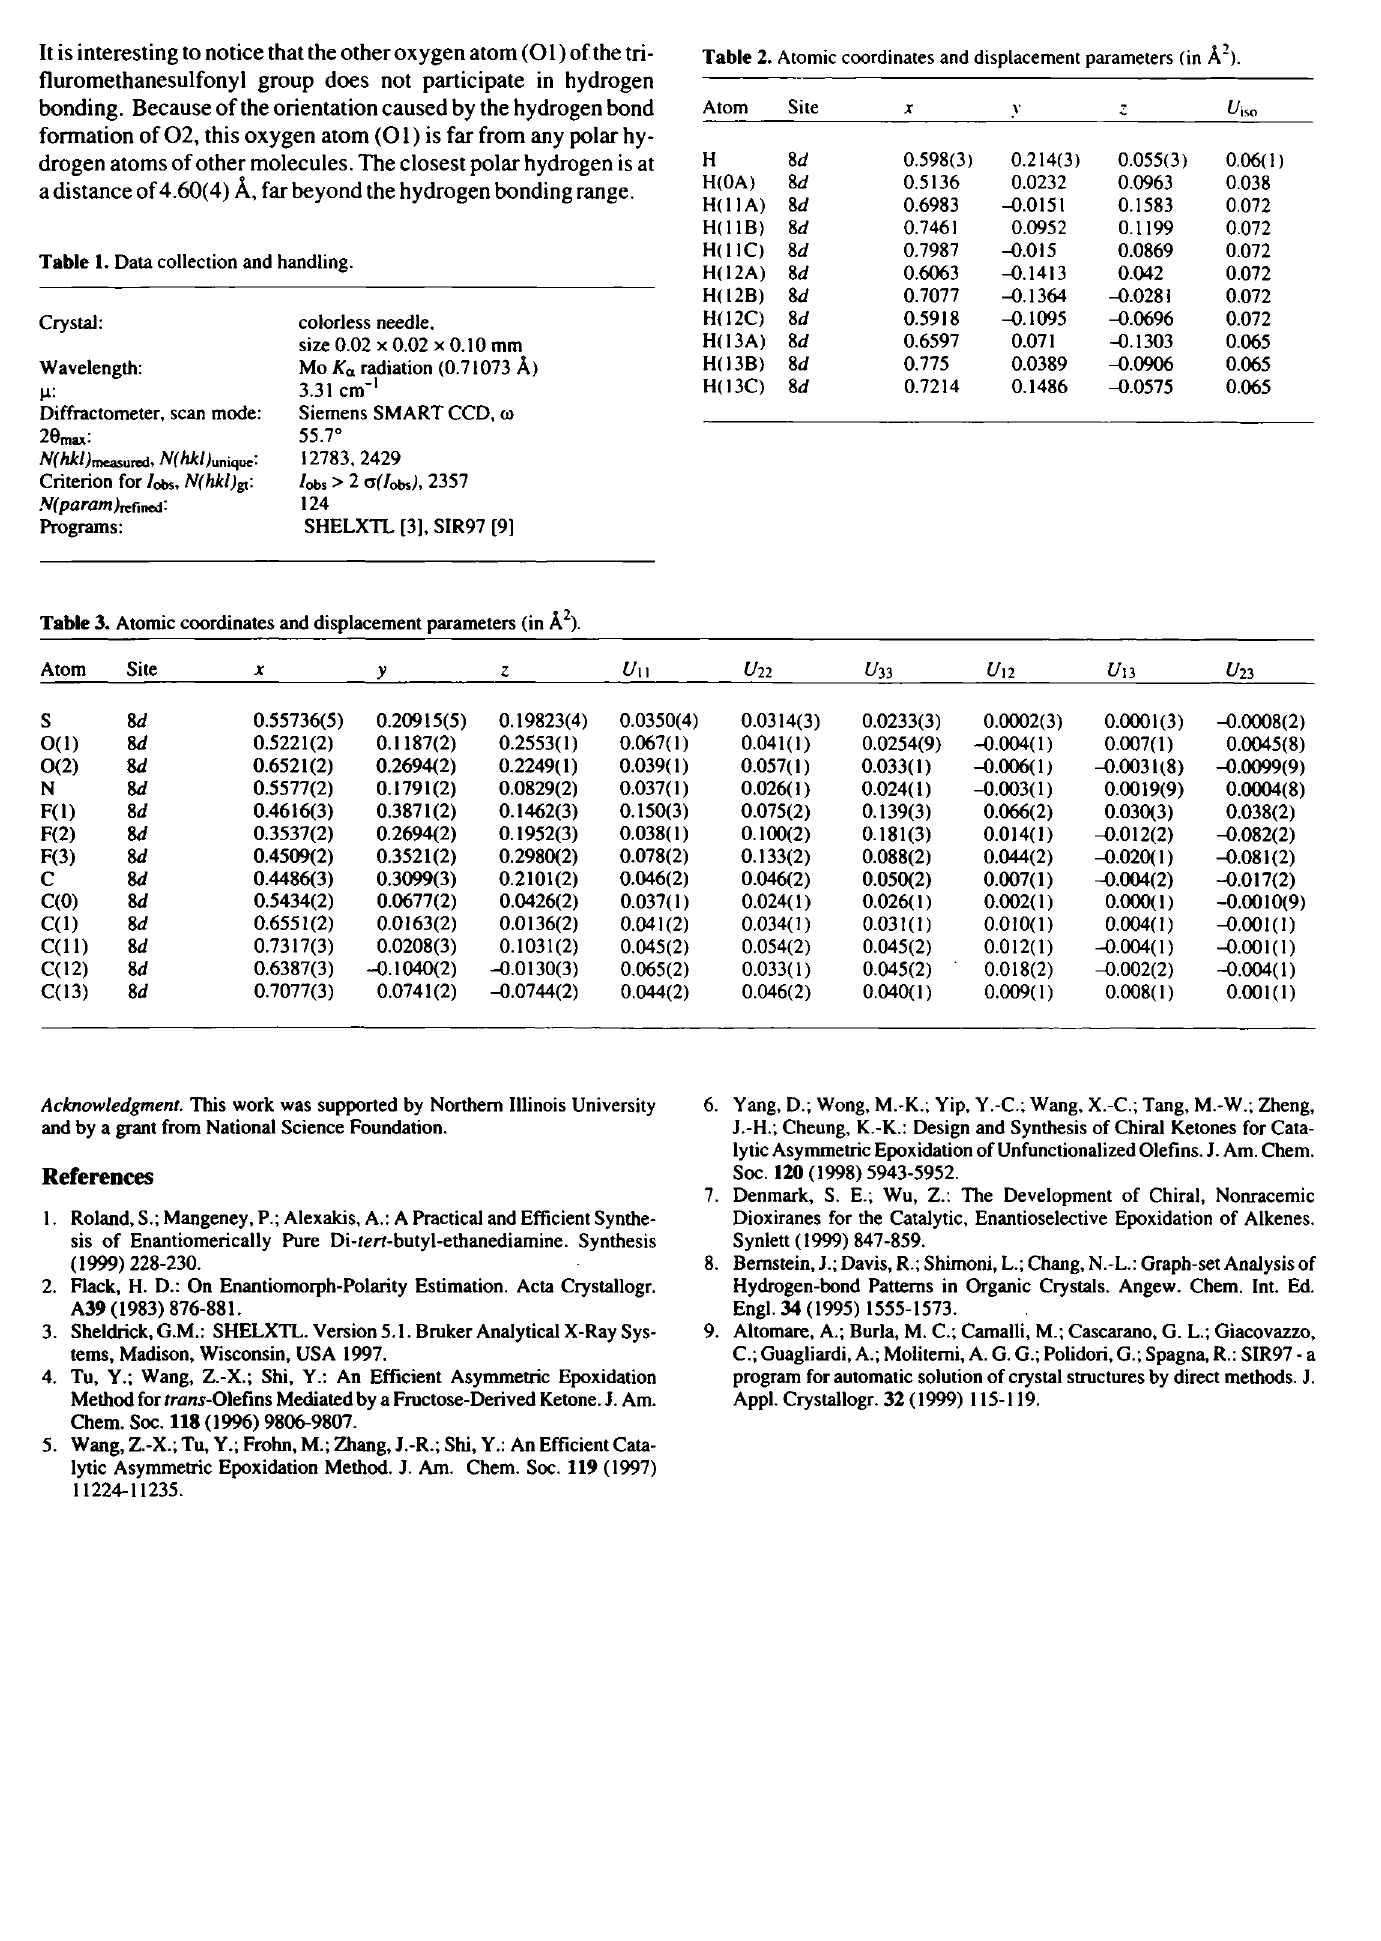
Table 2. Atomic coordinates and displacement parameters (in A").